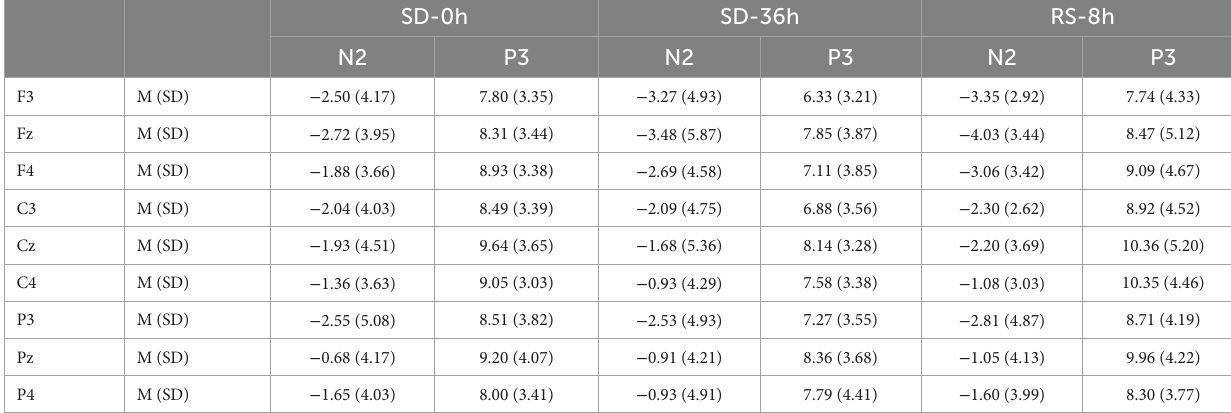
TABLE 6 Grand-average peak amplitude of the N2 and P3 components for correct responses across multiple electrode sites in three sleep states in the sleep deprivation (SD)